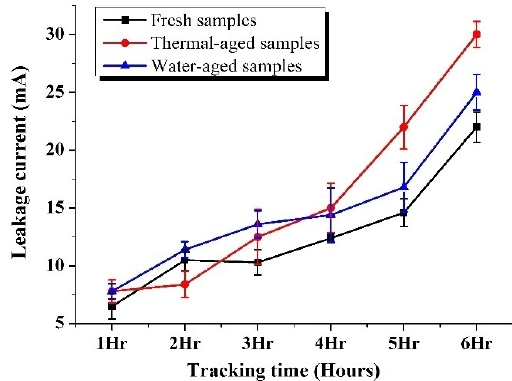
Figure 6. Variation of leakage current of fresh, thermal ‐ aged and water ‐ aged samples during tracking.